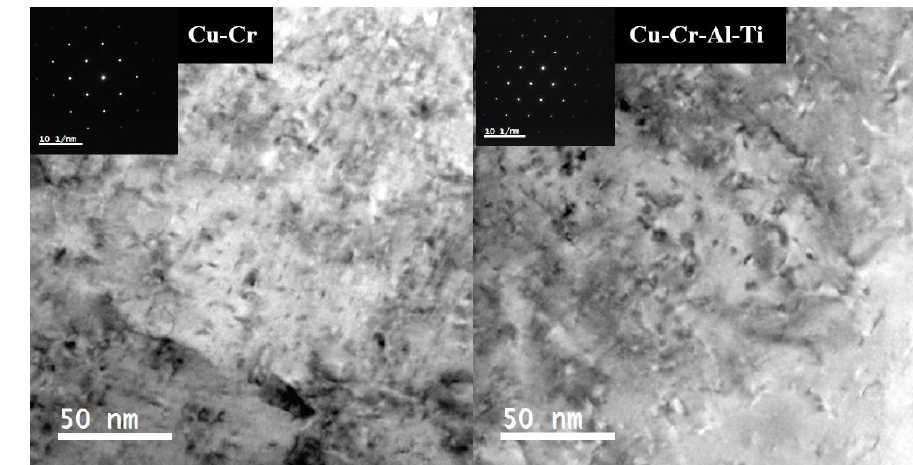
Figure 12. Solute concentration variation of Cu matrix by EPMA analysis.